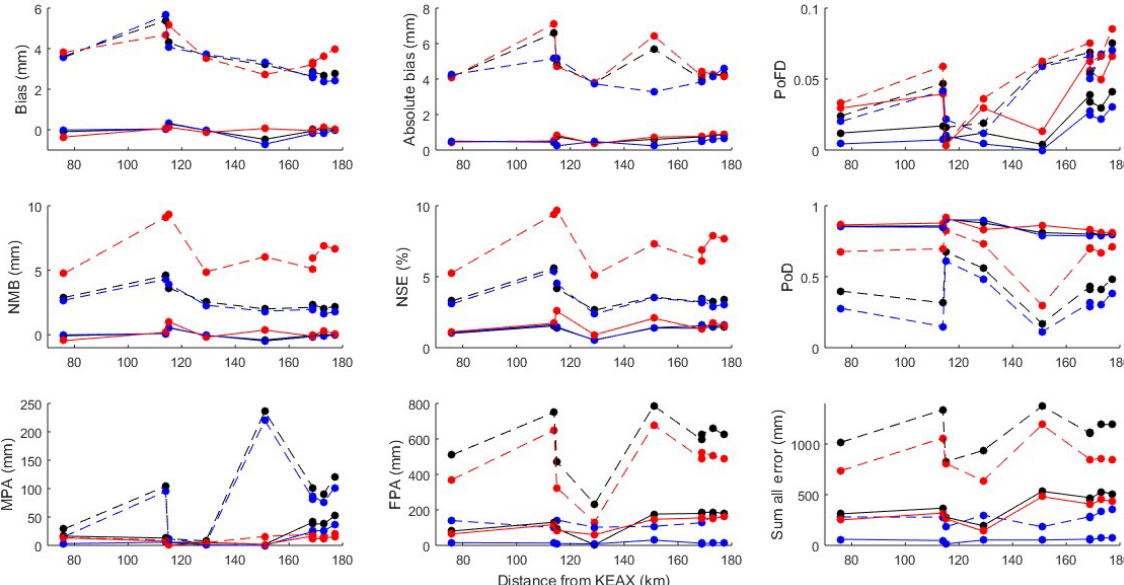
Figure 3. Values of analyses from the Kansas City radar. Dashed lines and points represent the analyses of the worst-performing algorithm ( R (ZDR,KDP)), while the solid lines and points represent the analyses of the best-performing algorithm ( R ( Z ,ZDR)). Red, blue, and black colors represent analyses conducted during the warm season, cool season, and overall, respectively.